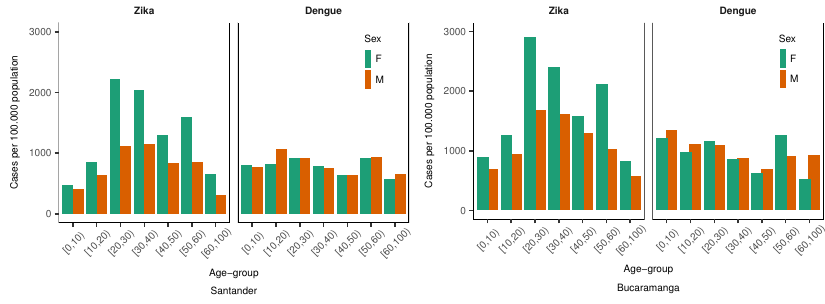
Figure 2. Incidence rate of Zika virus disease (ZVD) and dengue (cases per 100,000 people) by 10 year December 2016.